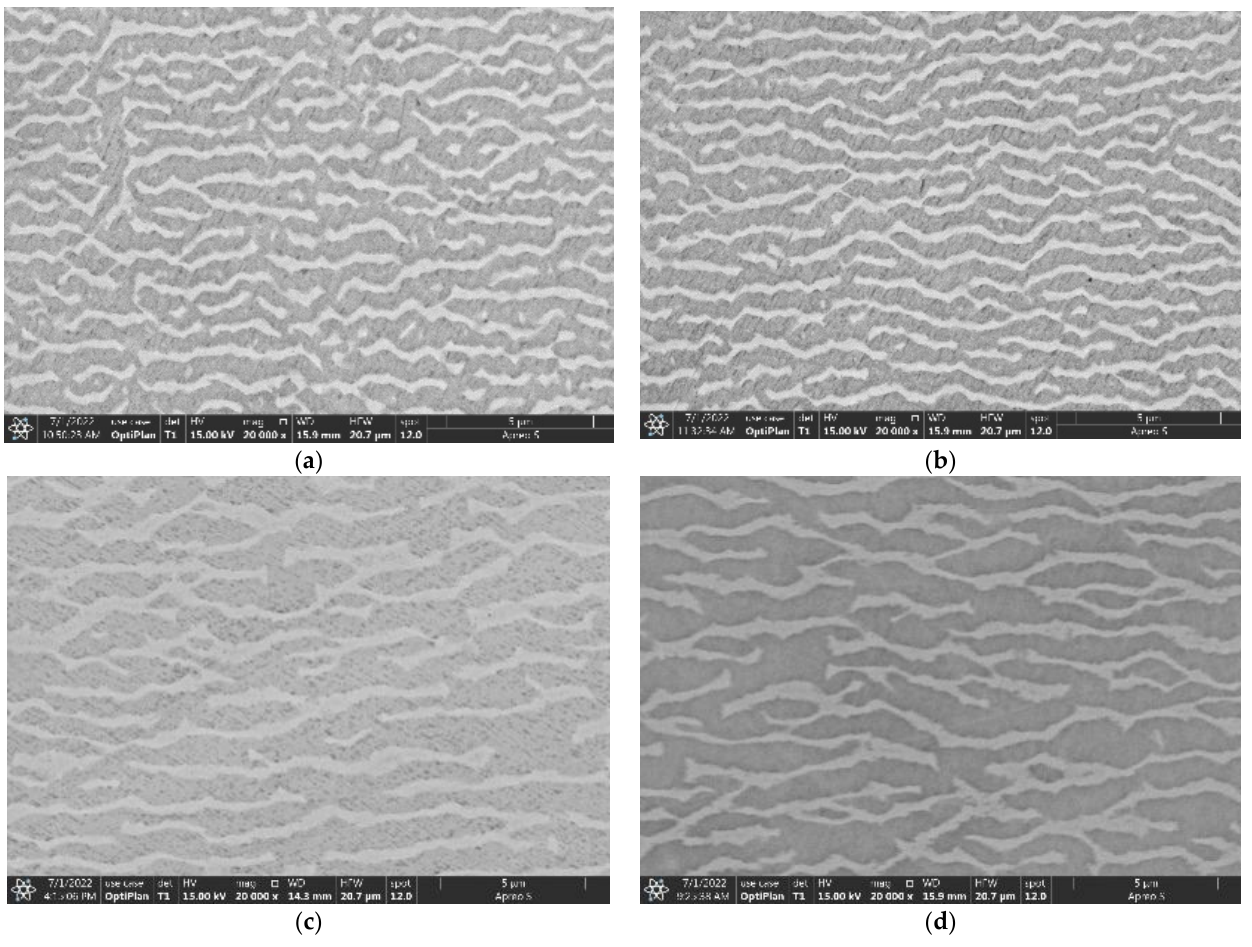
Figure 6. SEM-SE images of the γ ’ precipitates in the dendrite cores of the longitudinal sections of the experimental alloy after creep fracture at 1000 ◦ C/300 MPa after overheating exposed 1100 ◦ C/5 min ( a ) and 1100 ◦ C/120 min ( b ); SEM-SE images of the γ ’ precipitates in the dendrite cores of the longitudinal sections of the experimental alloy after creep fracture at 1100 ◦ C/130 MPa after overheating exposed 1100 ◦ C/5 min ( c ) and 1100 ◦ C/120 min ( d